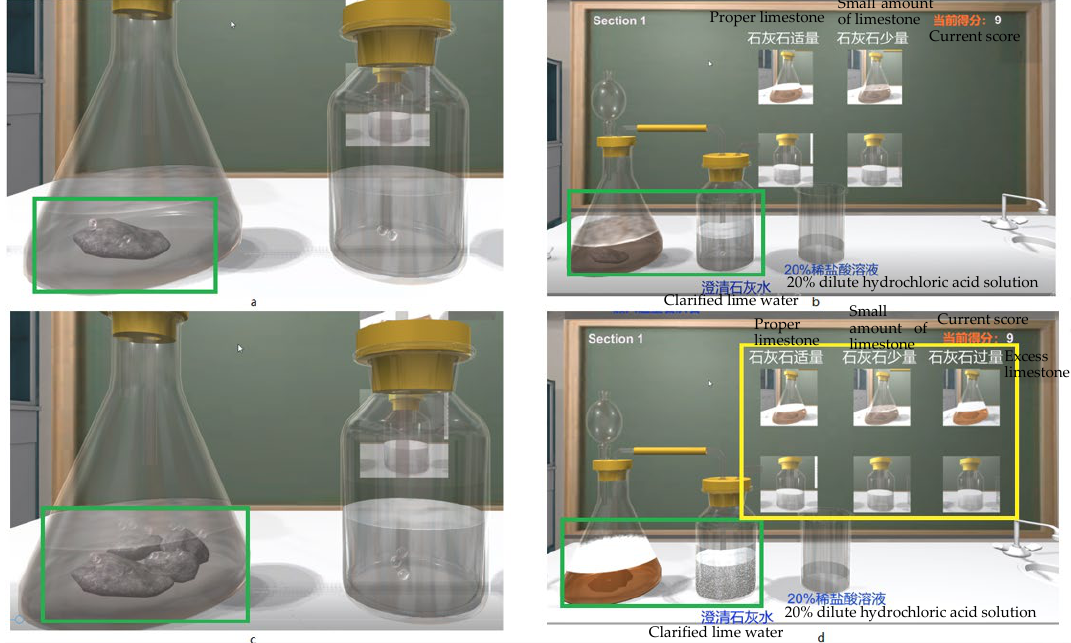
Figure 11. Limestone and dilute hydrochloric acid experiment scene 6. ( a ). Experimental interface 1 for reaction of a small amount of limestone with dilute hydrochloric acid. ( b ). Experimental interface 2 for reaction of a small amount of limestone with dilute hydrochloric acid. ( c ). Experimental interface 1 of reaction between excess limestone and dilute hydrochloric acid. ( d ). Experimental interface 2 of reaction between excess limestone and dilute hydrochloric acid.